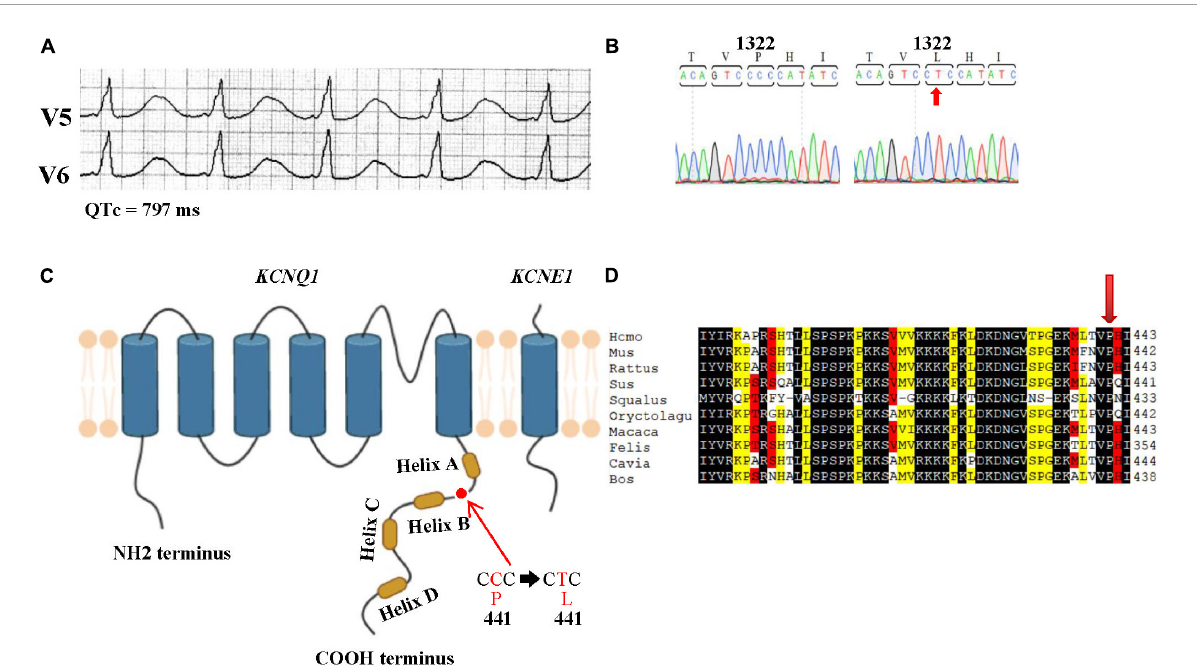
FIGURE1 Characterization of long QT syndrome type 1 in a patient with the P441L variant of KCNQ1 (potassium voltage-gated channel, subfamily Q member 1). (A) Patient electrocardiogram showing the corrected QT interval (QTc) interval is prolonged to 797 ms. (B) Sanger sequencing data showing the novel KCNQ1 mutation of C1322T in the P441L variant. Sequence analysis of genomic KCNQ1 obtained from the blood of the patient reveals a heterozygote missense mutation (C → T) at position 1322 of the KCNQ1 coding region (C1322T). (C) Schematic representation of KCNQ1 protein with the P441L variant; proline is replaced by leucine at position 441 of the cytoplasmic C-terminal domain (P441L). Created with BioRender.com. (D) Partial amino acid sequences of different species KCNQ1 homologs aligned at the position corresponding to tyrosine 441 of human KCNQ1 (arrow). Number, the position of the last amino acid of each partial sequence. The conserved motif is outlined in